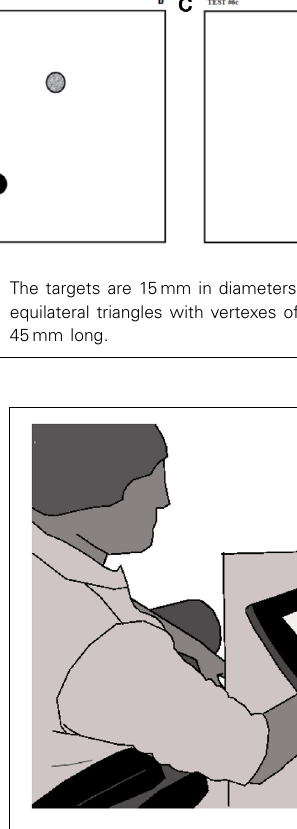
FIGURE 7 | Guiding sheet for the test involving oscillatory movements (#7 and #8). The black circle and the gray areas indicate respectively the starting and the target zones.